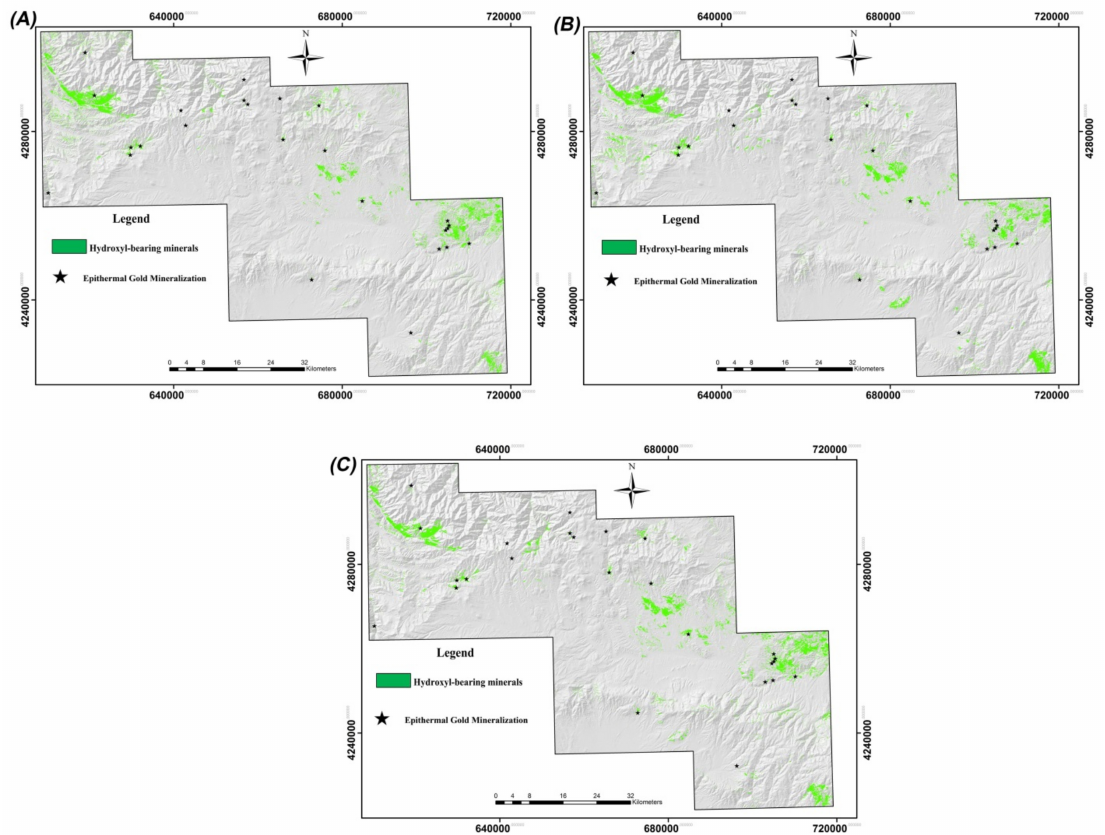
Figure 10. The PCA images derived from Landsat-7 ETM + , Landsat-8 and ASTER selected bands for mapping hydroxyl-bearing minerals in the study area overlaid on hill shade. ( A ) The PCA4 image of Landsat-7 ETM + ; ( B ) the PCA4 image of Landsat-8; ( C ) the PCA4 image of